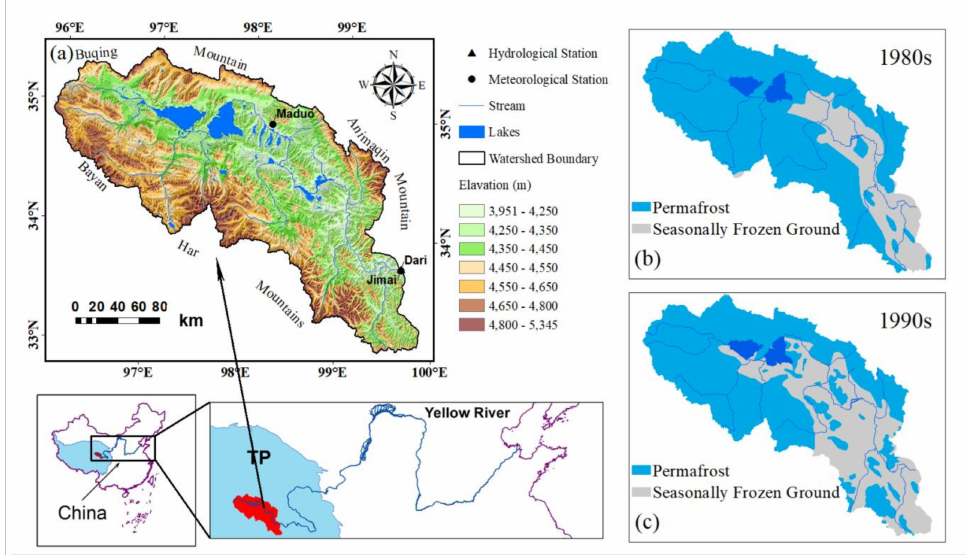
Figure 1. ( a ) Relative location of the study area in the Yellow River basin, distribution of the meteorological stations, and the outlet hydrological station; ( b ) frozen ground distribution in the 1980s; ( c ) frozen ground distribution in the